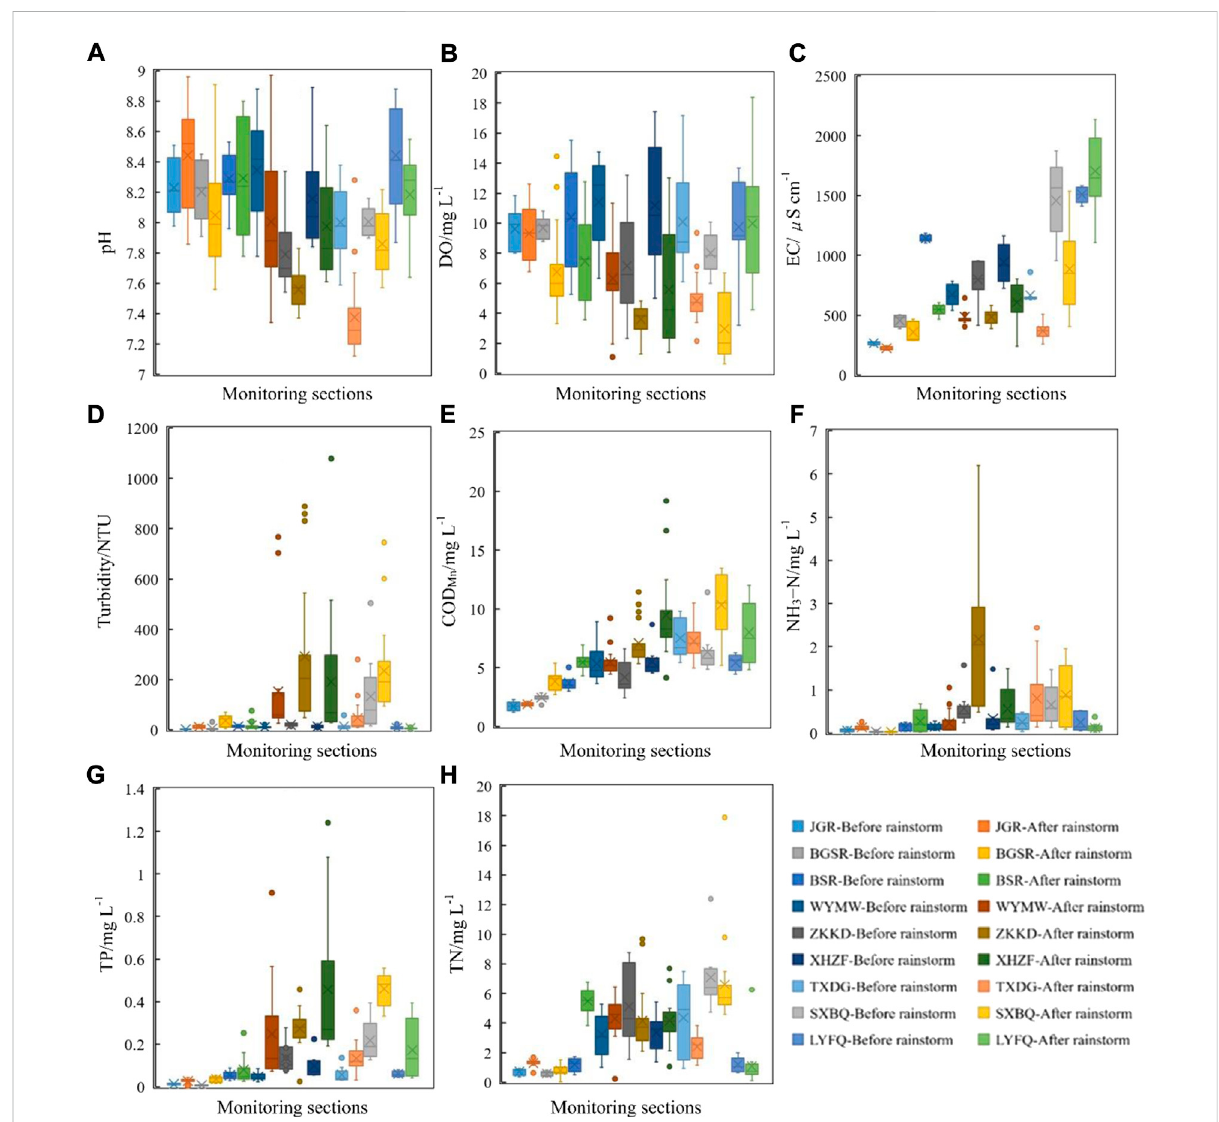
FIGURE 6 ThedifferencesofthepH (A) ,DO (B) ,EC (C) ,Turbidity (D) ,COD Mn (E) ,NH 3 − N (F) ,TP (G) ,andTN (H) ateachmonitoringstationbeforeandafter the rainstorm. Boxplots show the maximum, upper-quartile, median, lower-quartile, and minimum of the distribution across